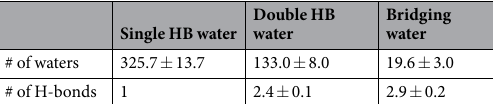
Table 1. Average number of waters and water–protein hydrogen bonds a . a Average ± standard